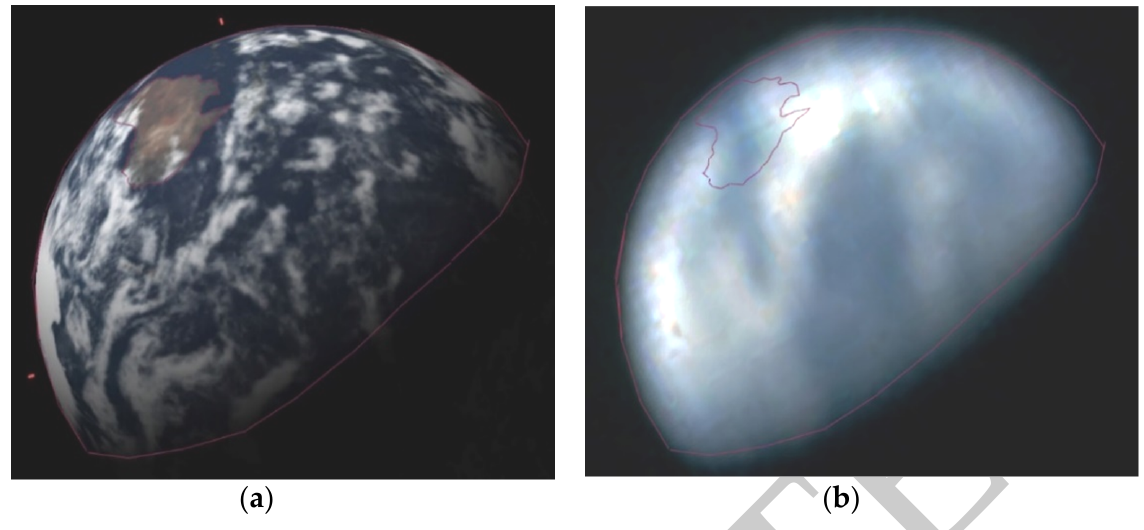
Figure 6. Comparison of the Earth and its continents as shown by Stellarium software simulation and photo AS17-134-20384 (the equivalent of photo GPN-2000-00113) found in the Apollo 17 Image Library. ( a ) Stellarium software simulation of the view over Apollo 17 landing site showing the Earth as it would be seen on 12 December 1972, at 03:58:54. ( b ) Earth as seen in the photo AS17-134-20384 and found in the Apollo 17 Image Library. The red lines indicate the shape of Earth and Australia transferred from Stellarium simulation.